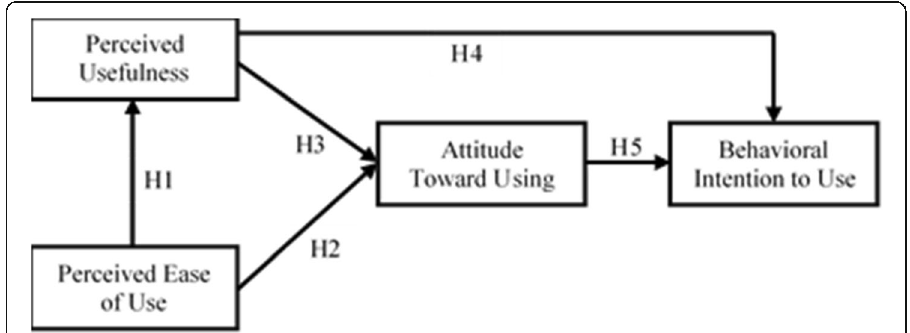
Fig. 2 Modified TAM for e-learning by Masrom